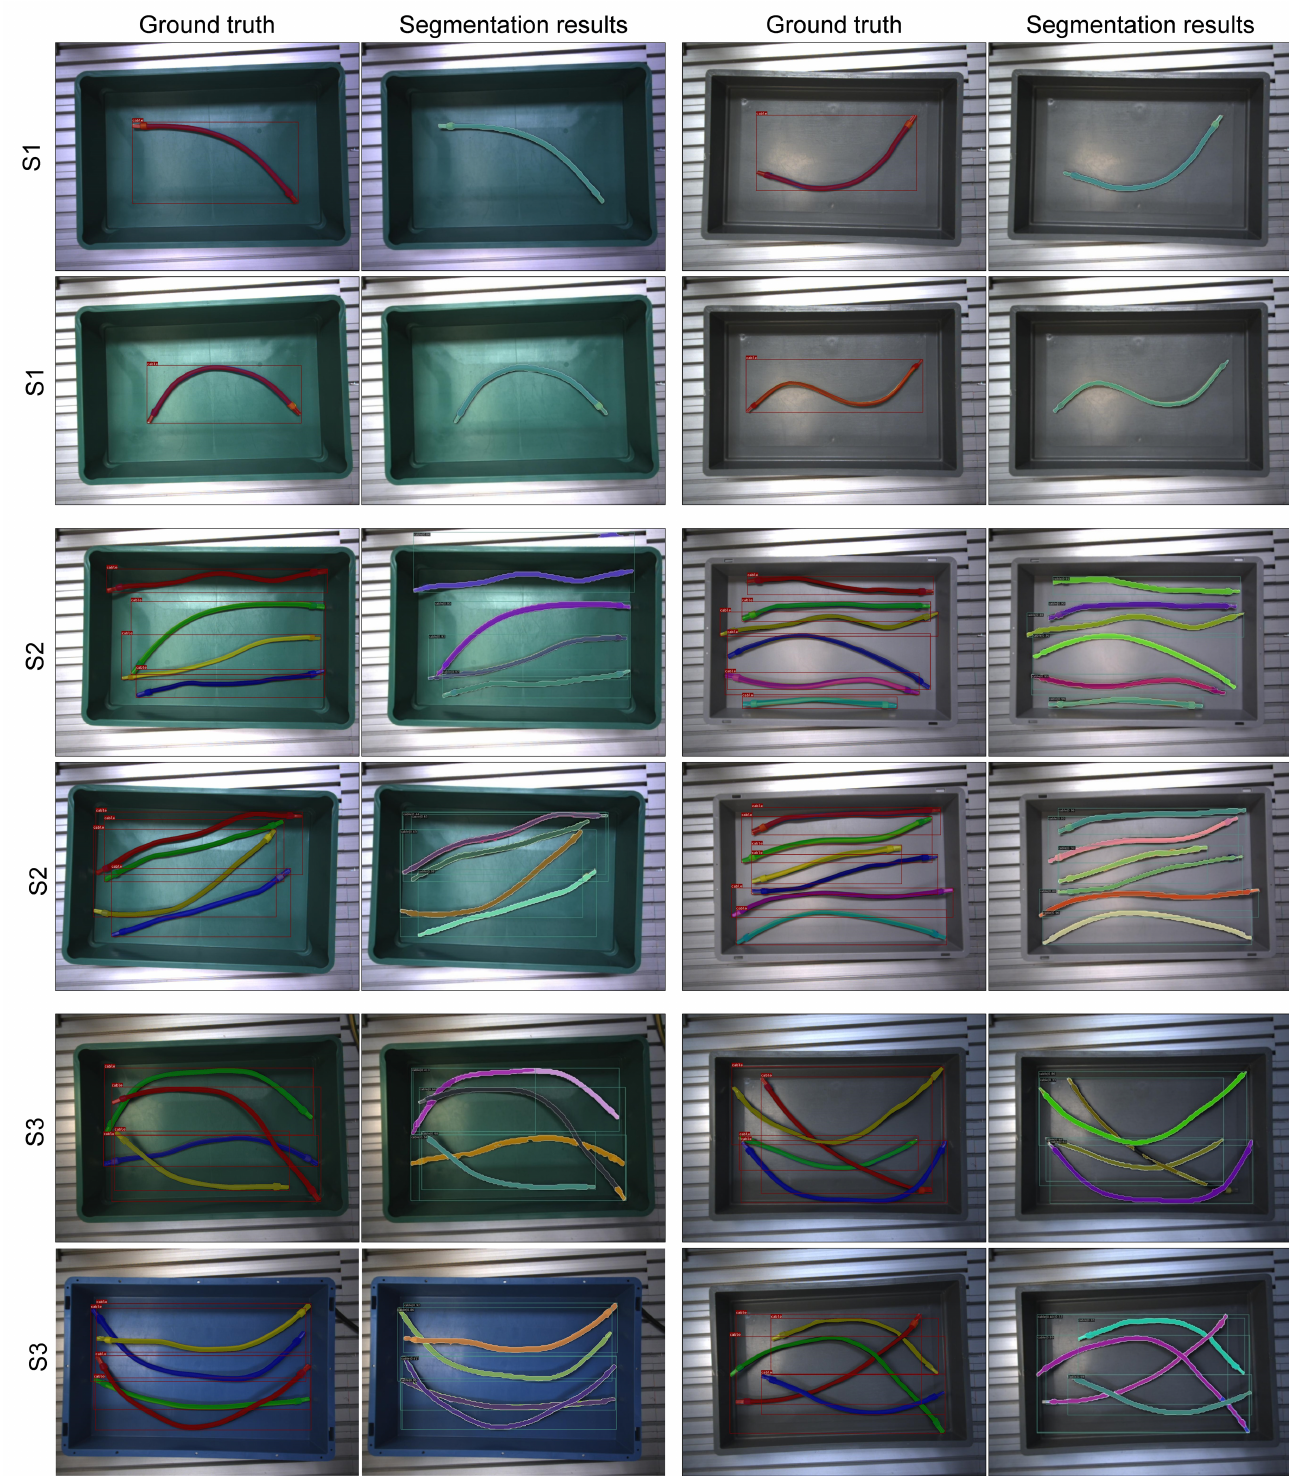
Figure A1. Ground truth masks and instance segmentation results for the visual replication in the scenarios S1, S2 and